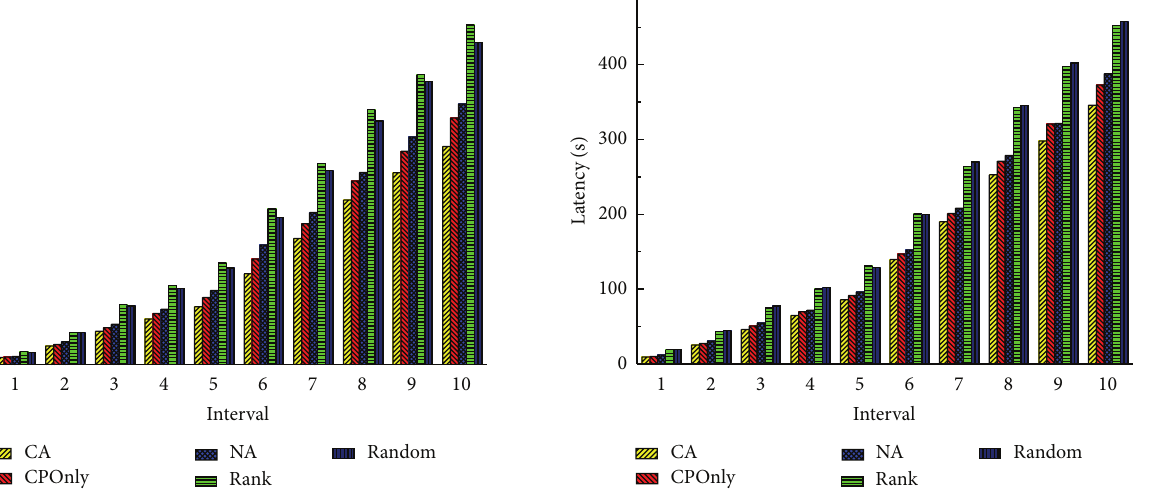
Figure 8: Total latency of all services (20 nodes).